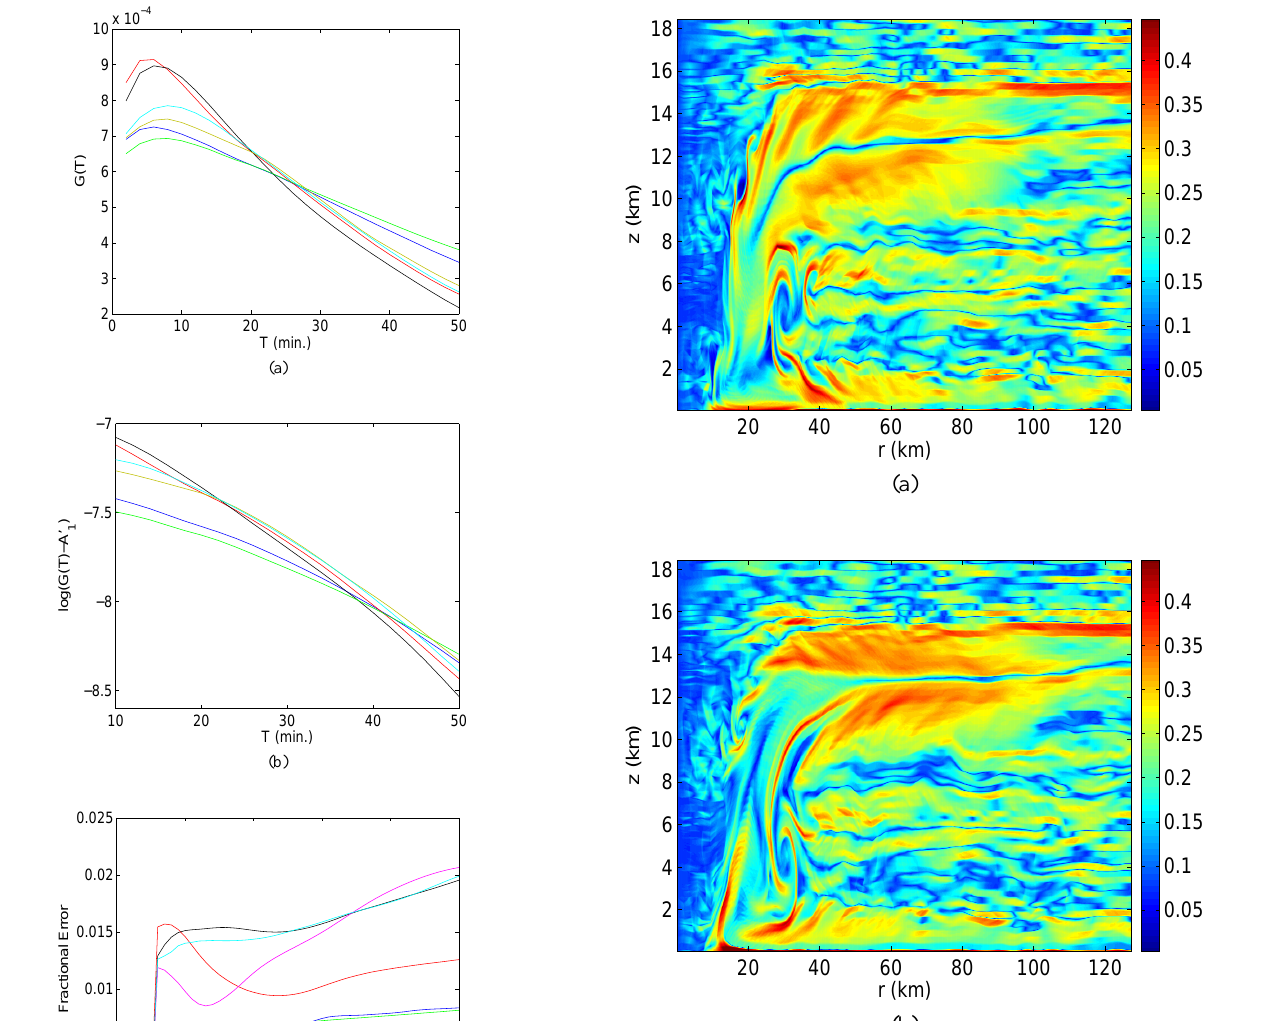
Fig. 5. Forward (a) and backward (b) time FTLE fields integrated 20 minutes with an initial time of 400 minutes.